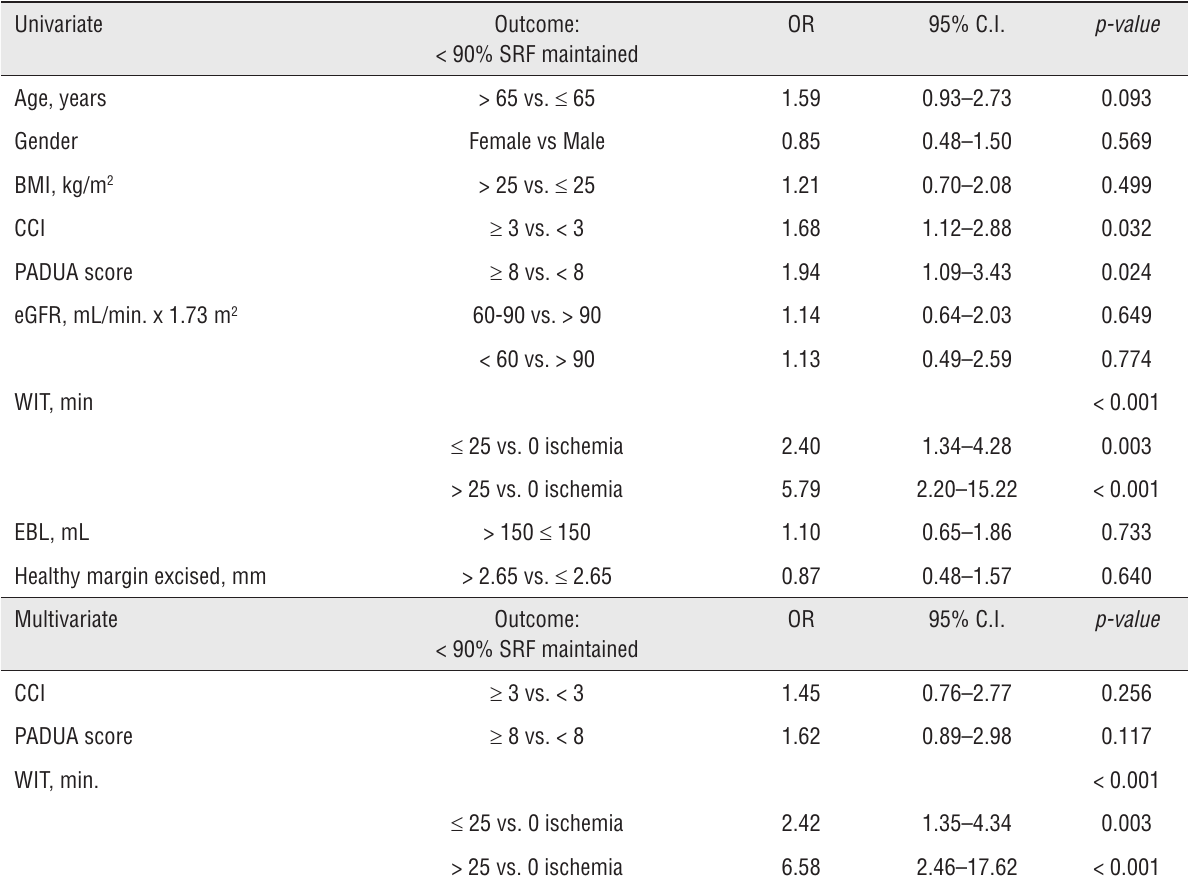
Table 4 - Univariate and Multivariate Logistic Regression Models. Univariate